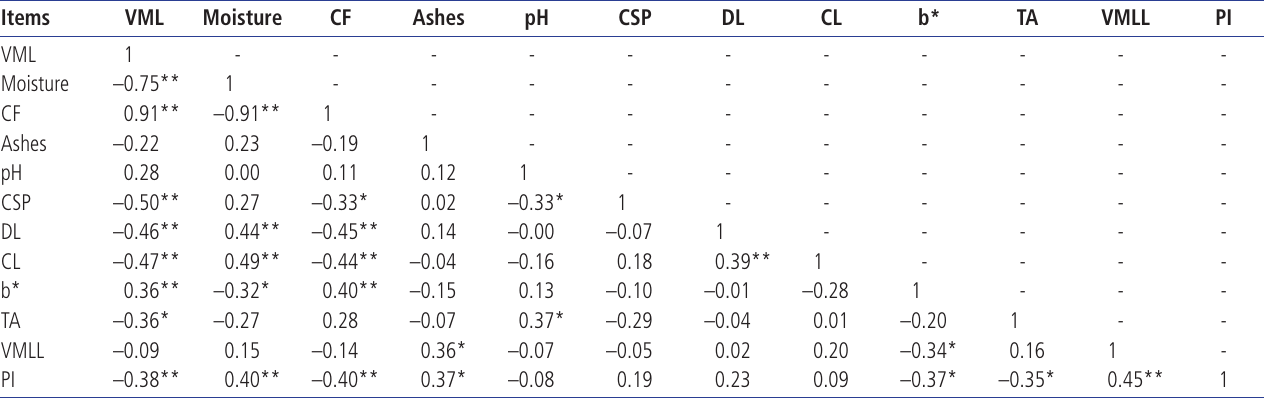
Table 2. Correlation coefficients among visual marbling levels, meat physicochemical quality traits, consumer responses (n = 389) on tenderness acceptability, and VML liking, and purchase intent of pork Longissimus dorsi